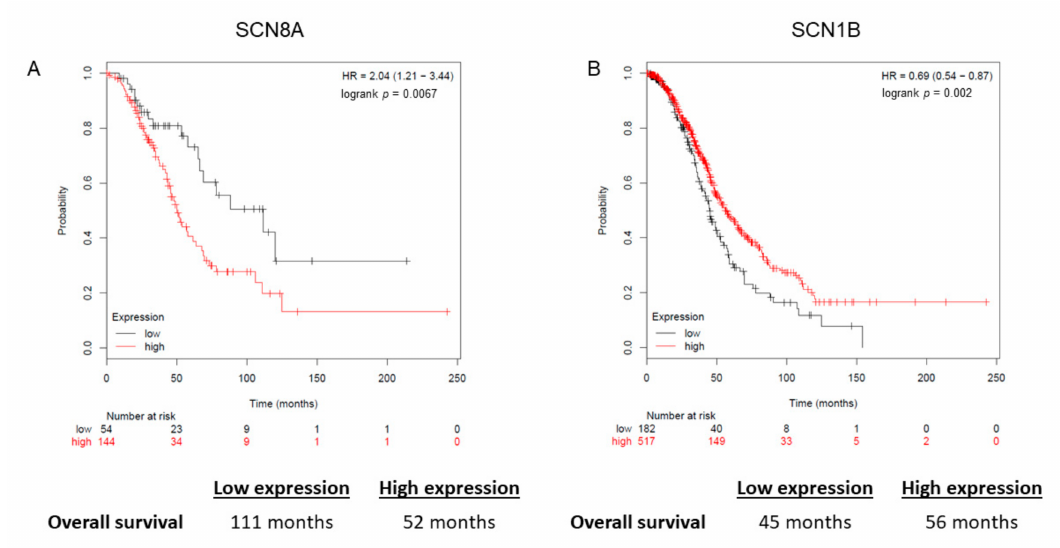
Figure 2. Overall survival after optimal cytoreductive surgery followed by platinum-based chemotherapy stratified by tumor voltage gated sodium channel expression of ( A ) SCN8A and ( B ) SCN1B.